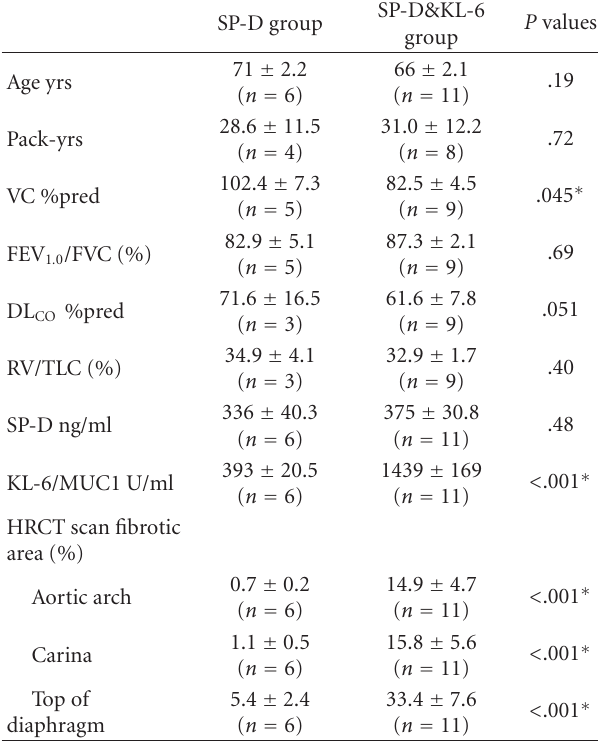
Table 2: Characteristics of patients in SP-D and SP-D&KL-6